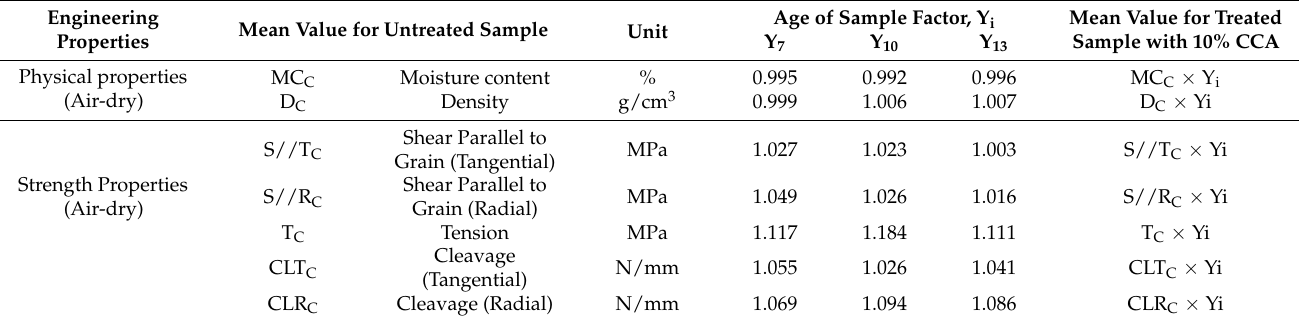
Table 6. Calculation of mean value of engineering properties of treated Acacia hybrid sample under 10% chrome arsenic (CCA) treatment at air-dry condition using the mean value of the untreated